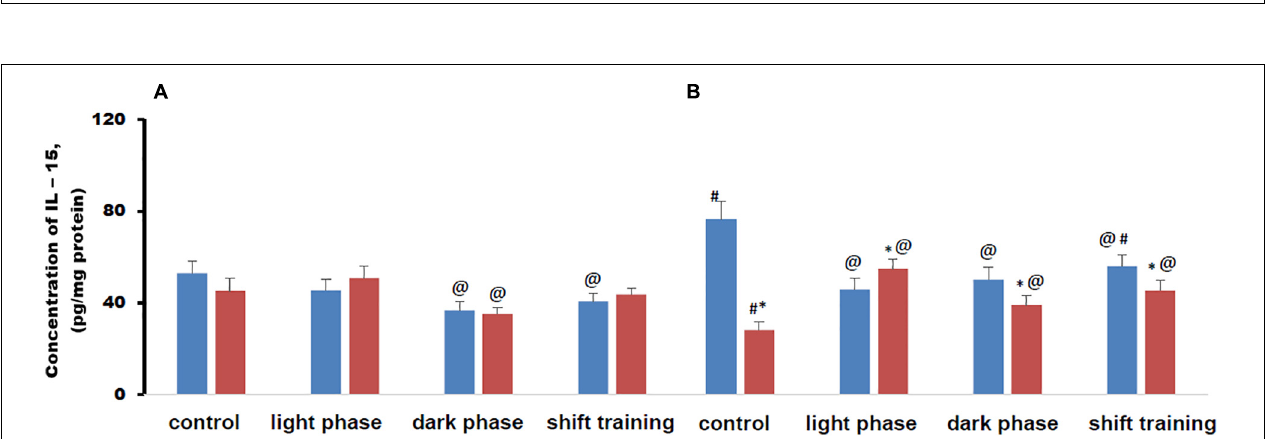
FIGURE 6 | Concentration of interleukin 15 (IL-15) in mice muscle tissue (pg/mg protein). Panel (A) shows young-age mice. Panel (B) shows old-age mice. Blue columns represent Chow diet and red columns represent High fat diet. Data are presented as the mean ± error of the mean. *Significantly different ( p < 0.05) from Chow diet. #Significantly different ( p < 0.05) from young-age mice. @Significantly different ( p < 0.05) from control.